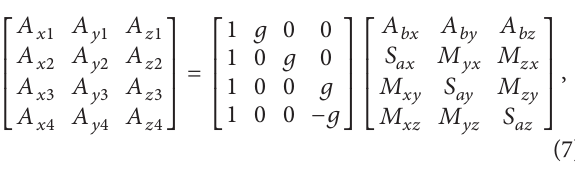
𝑖 = 𝑥, 𝑦, 𝑧 ; 𝑚 = 1, 2, 3, 4 . The system status equation of acceleration channel of RLG SINS can be given